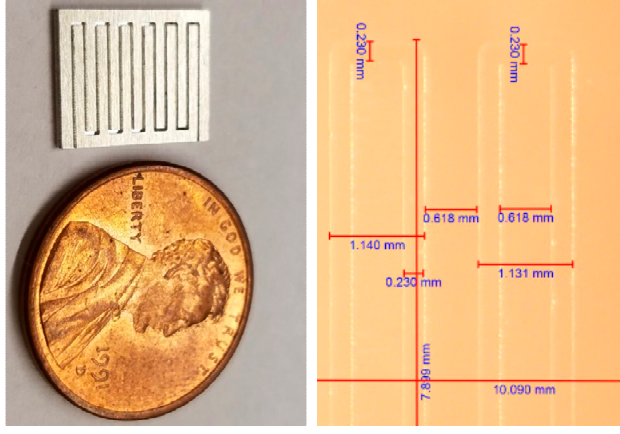
Figure 12. Micro-fluidic channel.